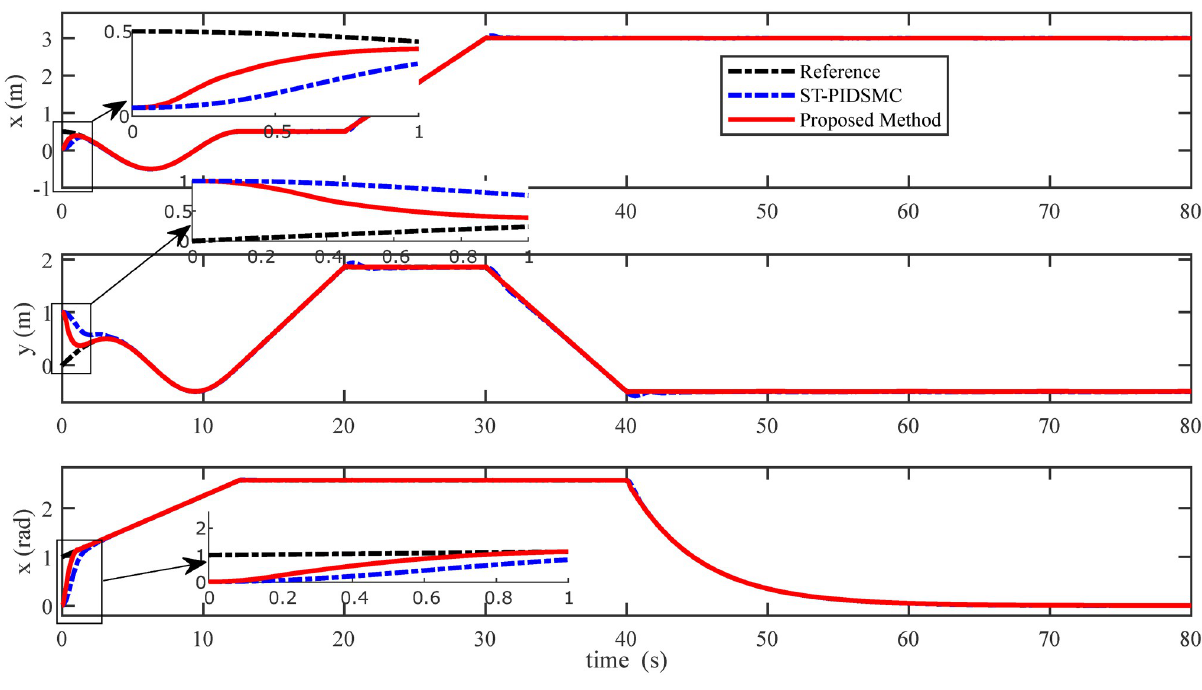
Fig 5. Results of the position under the proposed and ST-PID-SM controllers.